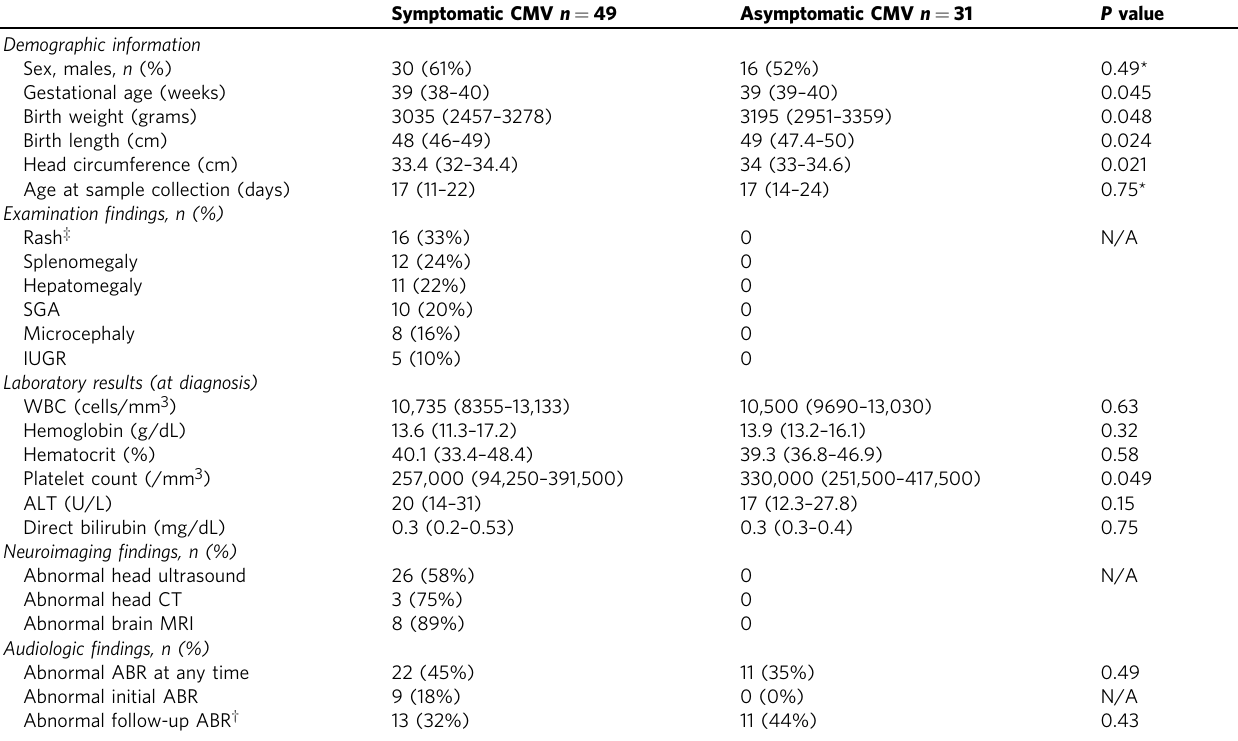
Table 2 Clinical information of infants with congenital cytomegalovirus